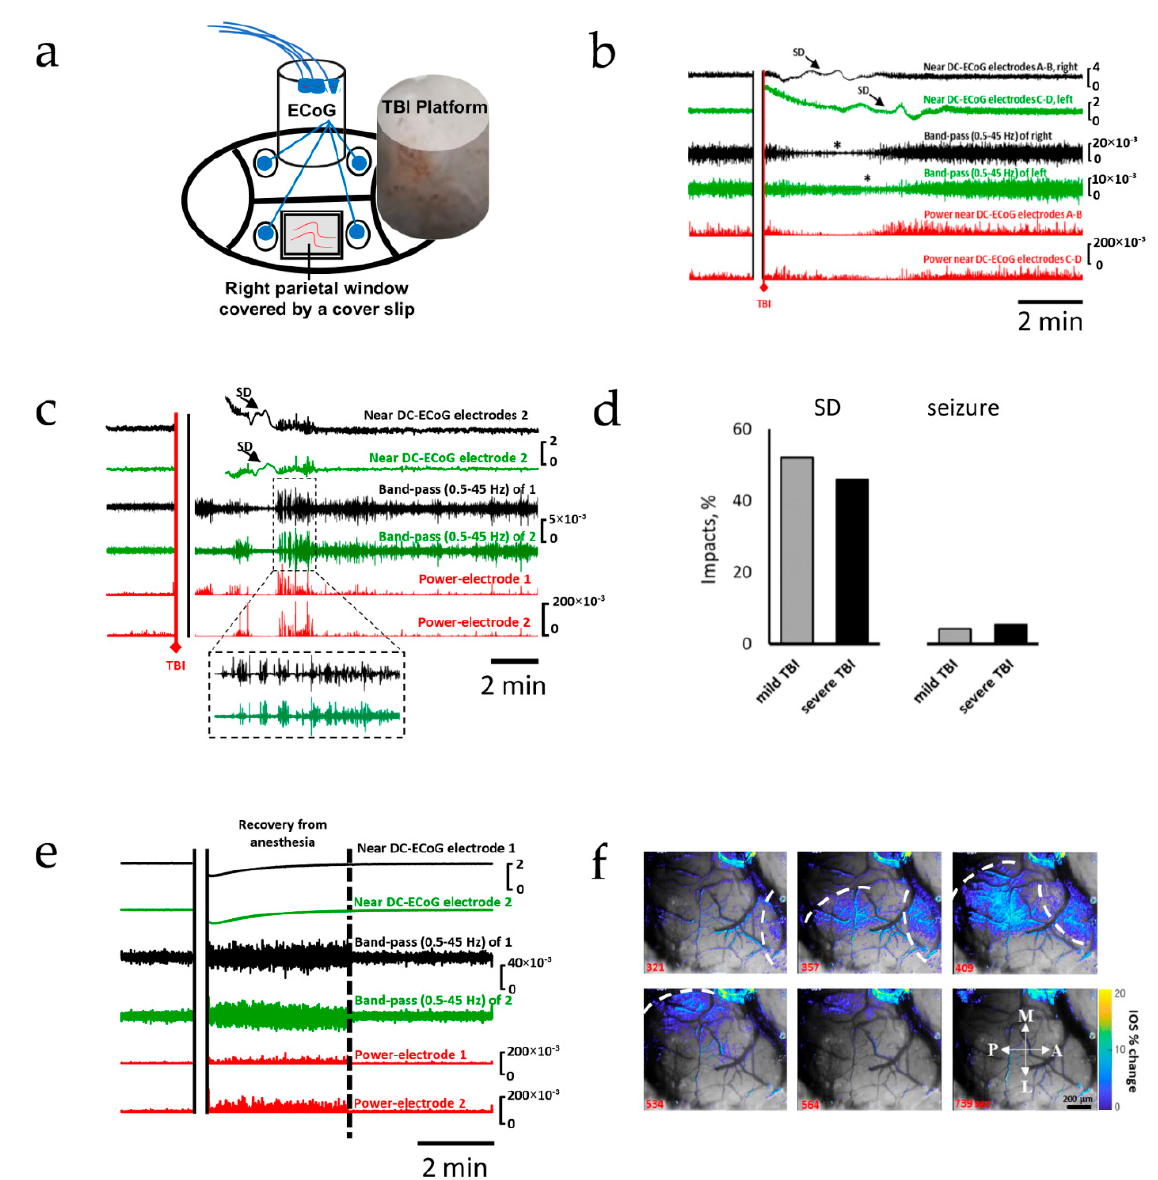
Figure 1. Spreading depolarization is the earliest and most common electrophysiological event after TBI. The upper two traces in each panel show raw ECoG recordings (band-pass: 0.02–100 Hz). The 3rd and 4th traces show band-passed (0.5–45 Hz) activity. Recordings from both the right (black) and left (green) hemispheres are shown. The 5th and 6th traces (red) show the squared activity (power near DC-ECoG). ( a ) Schematic representation of the general experimental setup. ( b ) Recording showing TBI-induced SDs recorded from both hemispheres. ( c ) Recording showing TBI-induced spreading depolarization with seizure activity immediately before and after SD; post-SD seizure is shown with expanded timescale. ( d ) Occurrence rates of SDs and seizures following mild and severe TBI. ( e ) Recording from a non-injured control; recovery from anesthesia is associated with a high-amplitude activity, which returns to pre-impact activity after regain of locomotion (dotted line). ( f ) Intravital microscopy showing changes in intrinsic optical signals during SD; changes in IOS are superimposed onto brain images; SDs propagated medially toward the midline; the dotted line represents the SD fronts. A: anterior; P: posterior; L: lateral; M: